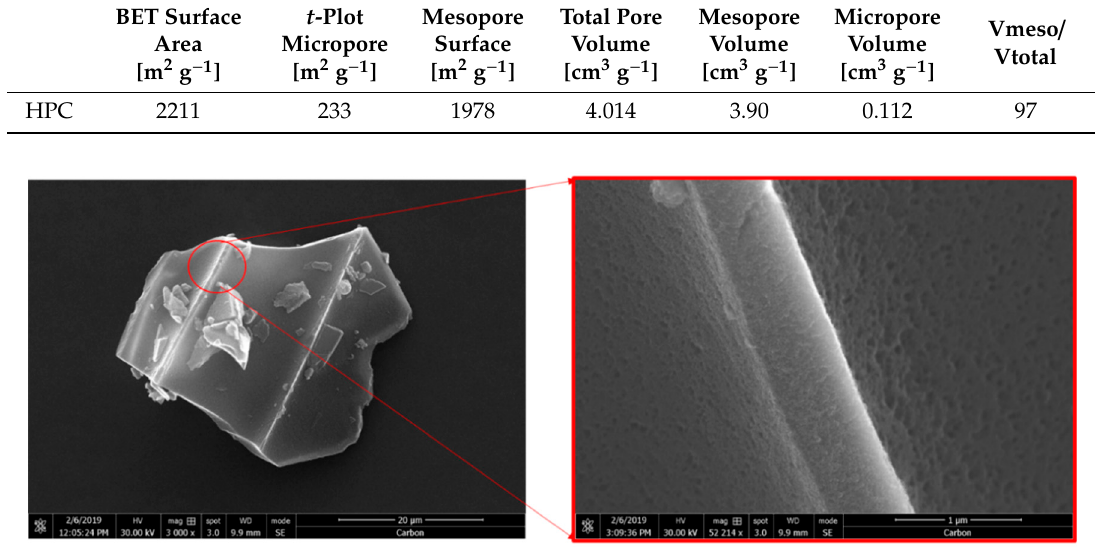
Figure 1. Representative SEM images of hierarchical porous carbon showing surface morphology and texture.